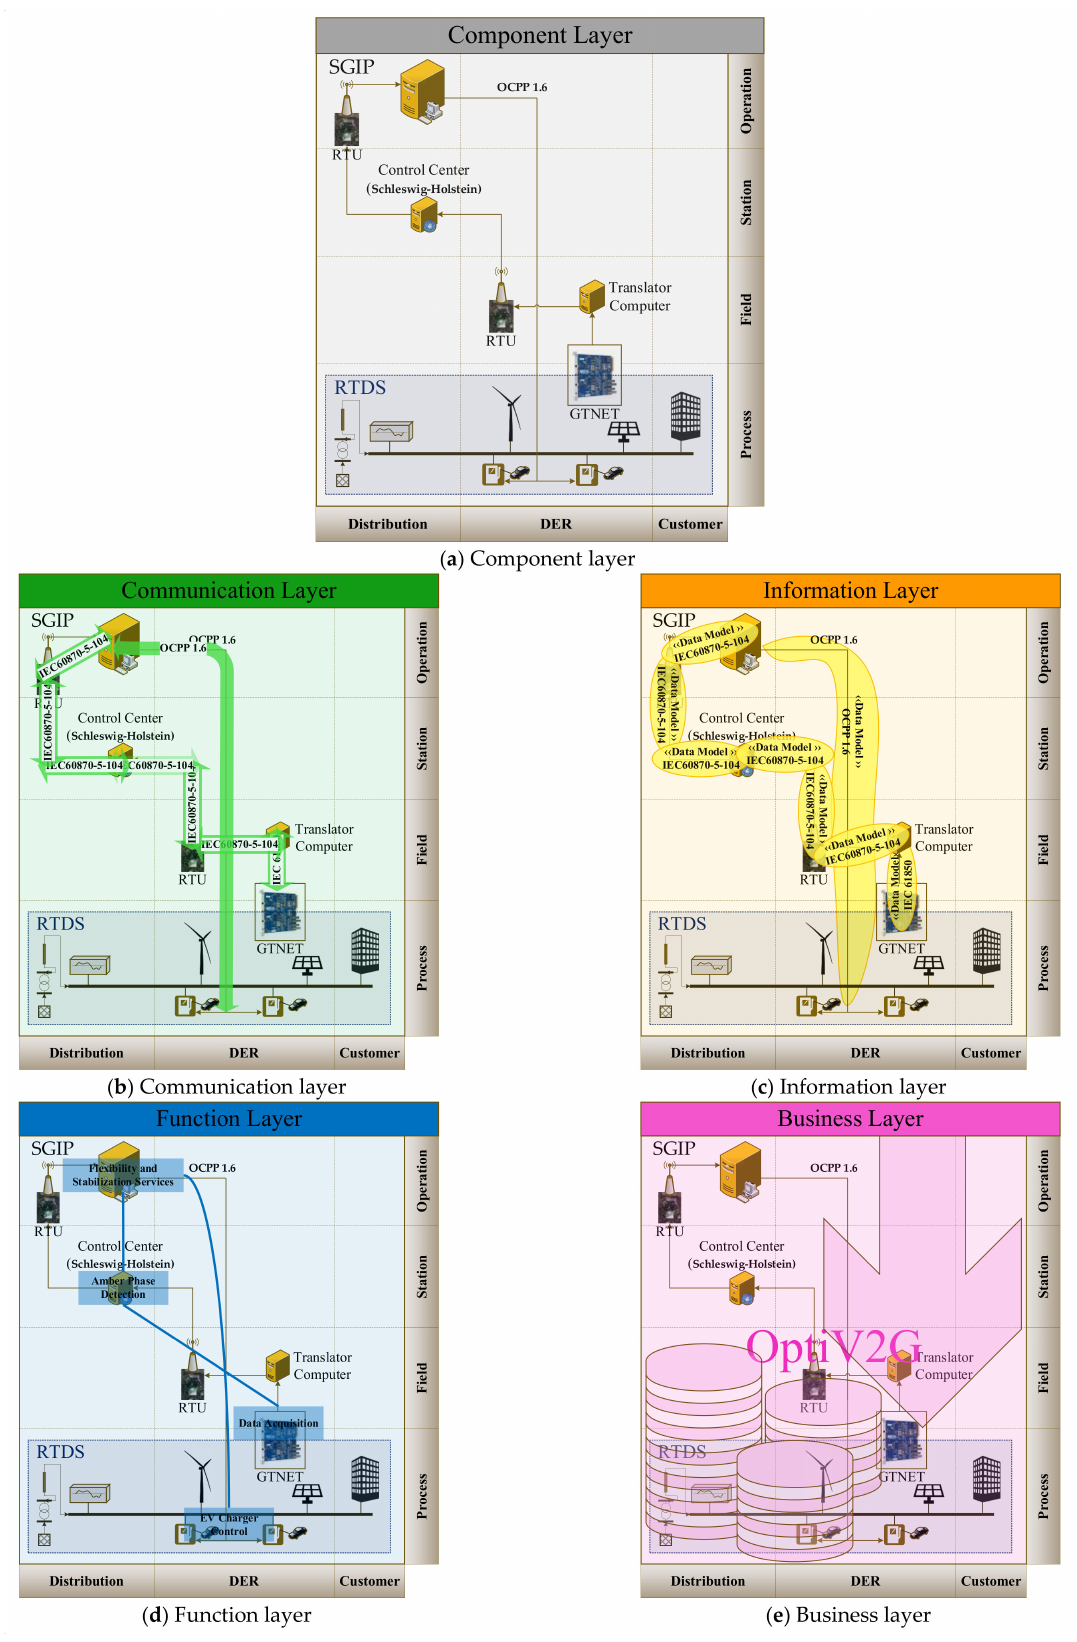
Figure 4. ( a ) Component, ( b ) communication, ( c ) information, ( d ) function and ( e ) business layers of the MEISTER SGAM